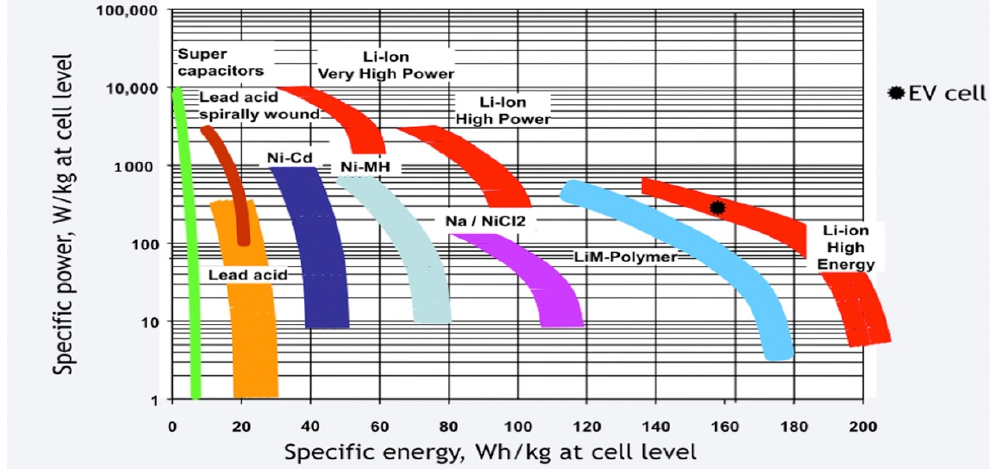
Figure 1. Various battery technologies used in EVs and their specific energy and specific power ratings. Table 1. Major electric car manufacturers and models, showing range, battery size, battery manufac- turers, location of battery pack assembly and location of battery cell production